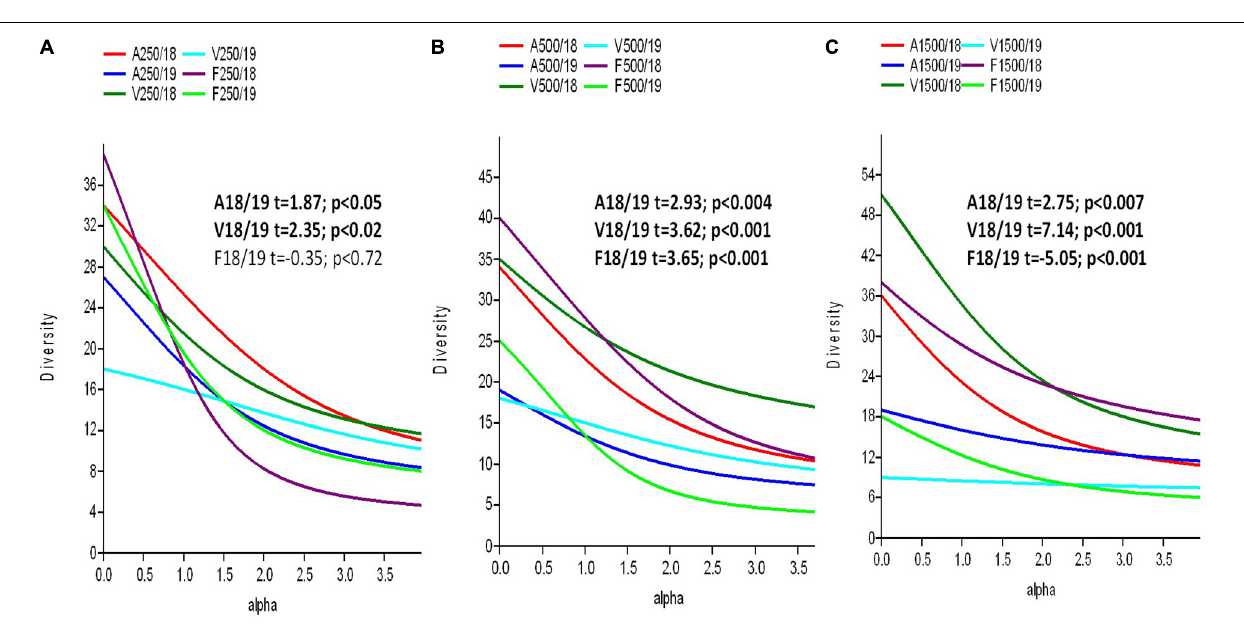
FIGURE 2 | Species richness (A–C) and abundances (D–F) of wild bees collected in 2018 and 2019 at 250 m (green bars), 500 m (brown bars), and 1,500 m (blue bars) from beehives in site A, V, and F. Different letters represent statistically significant differences between groups, i.e., Site A species at P < 0.05 level (Mann–Whitney U test followed by Tukey’s test).